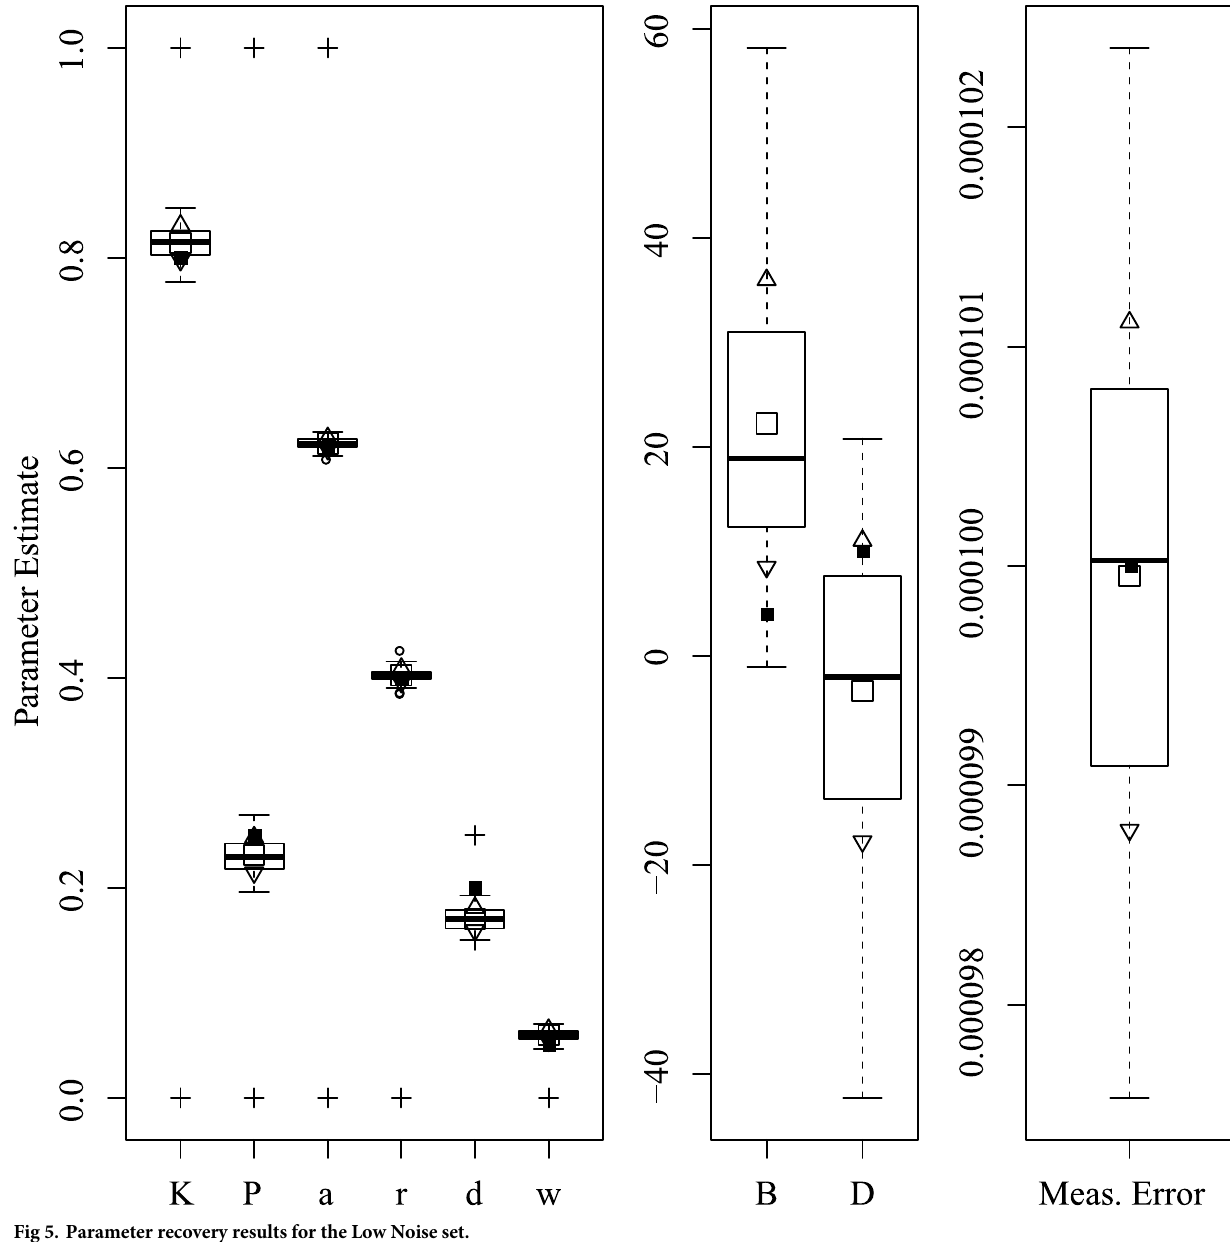
Fig 5. Parameter recovery results for the Low Noise